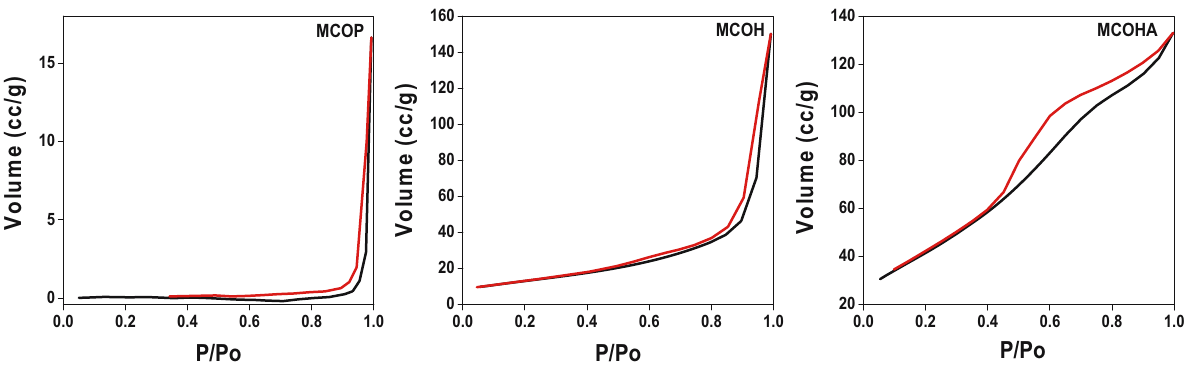
Figure 6: BET isotherms of the MCO synthetized by the method: ( left ) Pechini at 900°C, ( middle ) hydrothermal with NaOH at 500°C, and ( right ) Hydrothermal with acetates at 350°C.